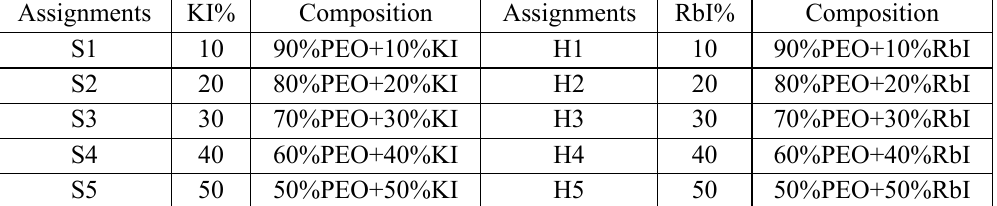
Table 1: Illustrate the composition of electrolytes S and H and weight ratio of salts. Assignments KI% Composition Assignments RbI%